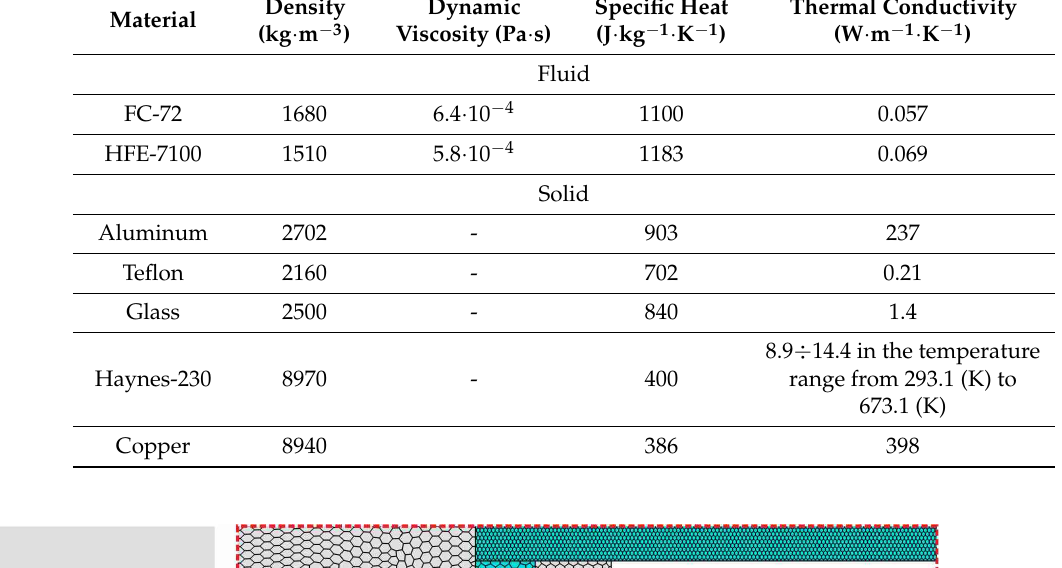
Table 3. The main physical properties of the materials used in the numerical calculations.